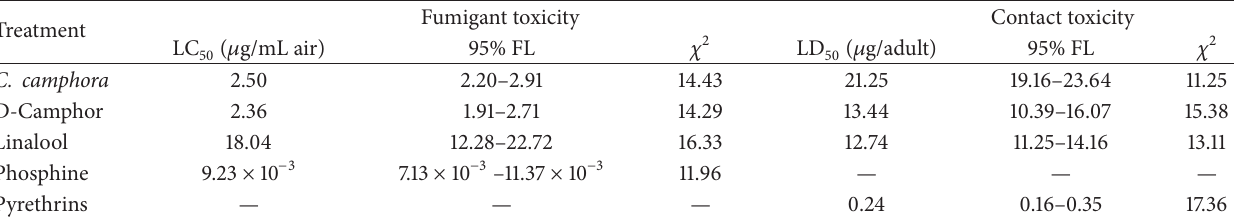
Table 2: Fumigant and contact toxicity of essential oil of Cinnamomum camphora leaves and its main components against Lasio- dermaserricorne